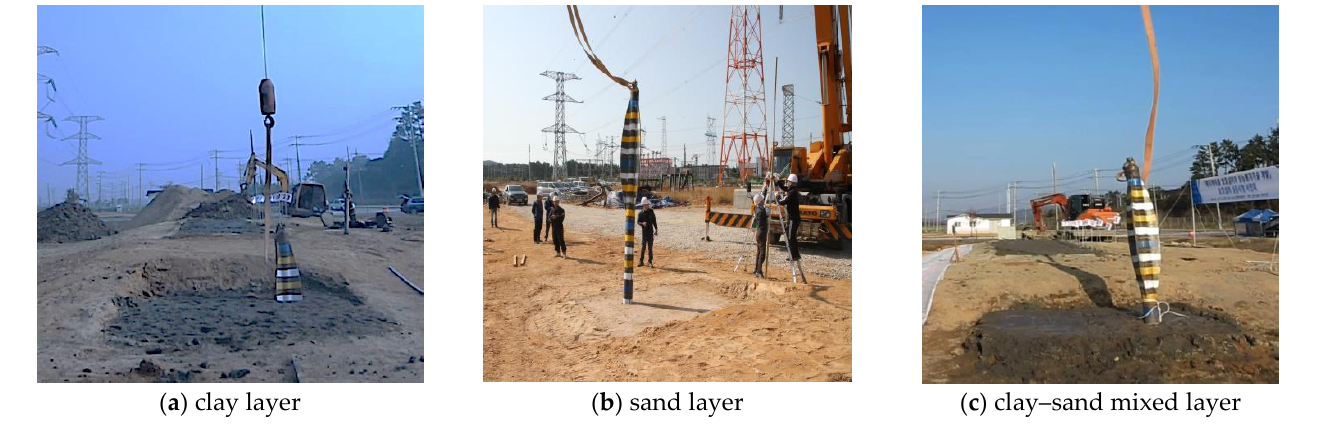
Figure 12. Field verification test results for soil penetration of anchor pile.